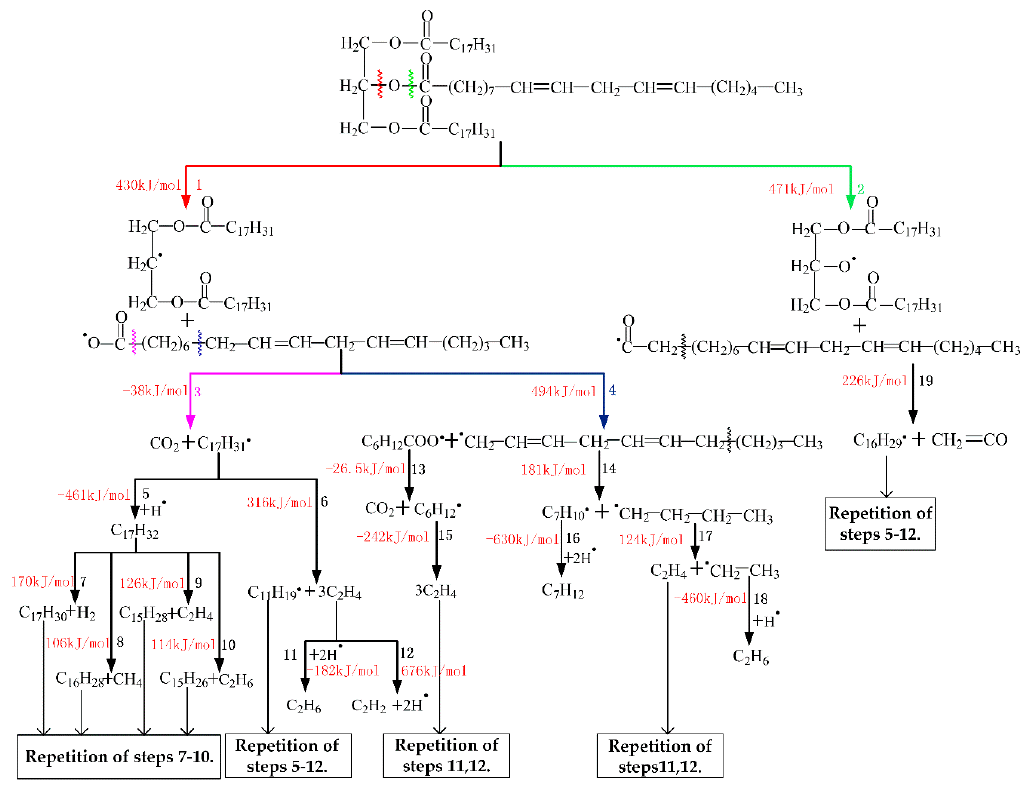
Figure 23. The principal decomposition pathways of linoleic ‐ type triglyceride and their standard enthalpies of reactions calculated using M06 ‐ 2x method.